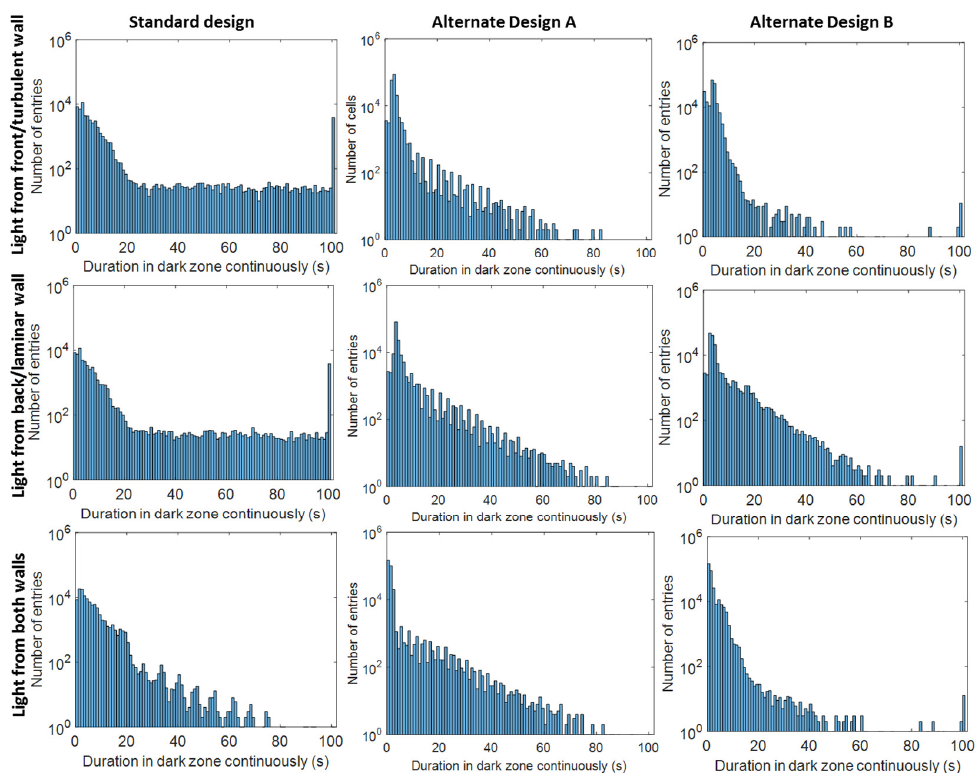
Figure 6. Time continuously spent in the dark zone by microalgal cells for three PBR designs and light incident from the turbulent side (front wall), laminar side (back wall), and both sides. Parameters used in the simulation were air flowrate of 0.5 L/min, concentration of 0.5 kg/m 3 , and total incident intensity of 1000 μE/m 2 s.